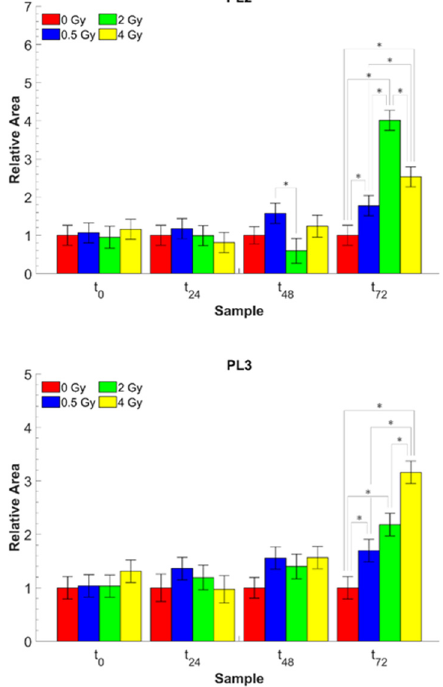
Figure 7. Comparison of the PL1, PL2, and PL3 absorbance area ratios for MCF-10A human breast epithelial cells for different proton doses and different fixation times. See Table 1 for details on the reported ratios (Mean ± SD), which are normalized to the corresponding ratio value of the non-irradiated sample. Asterisks indicate significant differences ( p < 0.05).